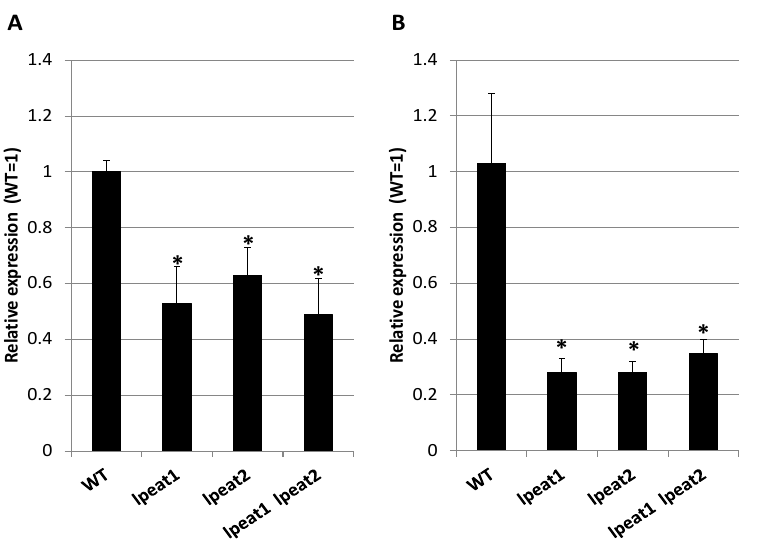
Figure 5. NBR1 gene expression analysis between different Arabidopsis thaliana lines. NBR1 transcript level in lpeat1 mutant, lpeat2 mutant and lpeat1 lpeat2 double mutant is displayed as relative to this gene’s expression level in WT (wild-type) with the assigned value of 1. The EF1ALPHA ( A ) and ACT2 ( B ) gene expression was treated as reference in qRT-PCR. Means ± SD are presented (n = 3). Asterisk (*) indicates significant difference compared with WT in “mean difference two sided test” at α = 0.05.